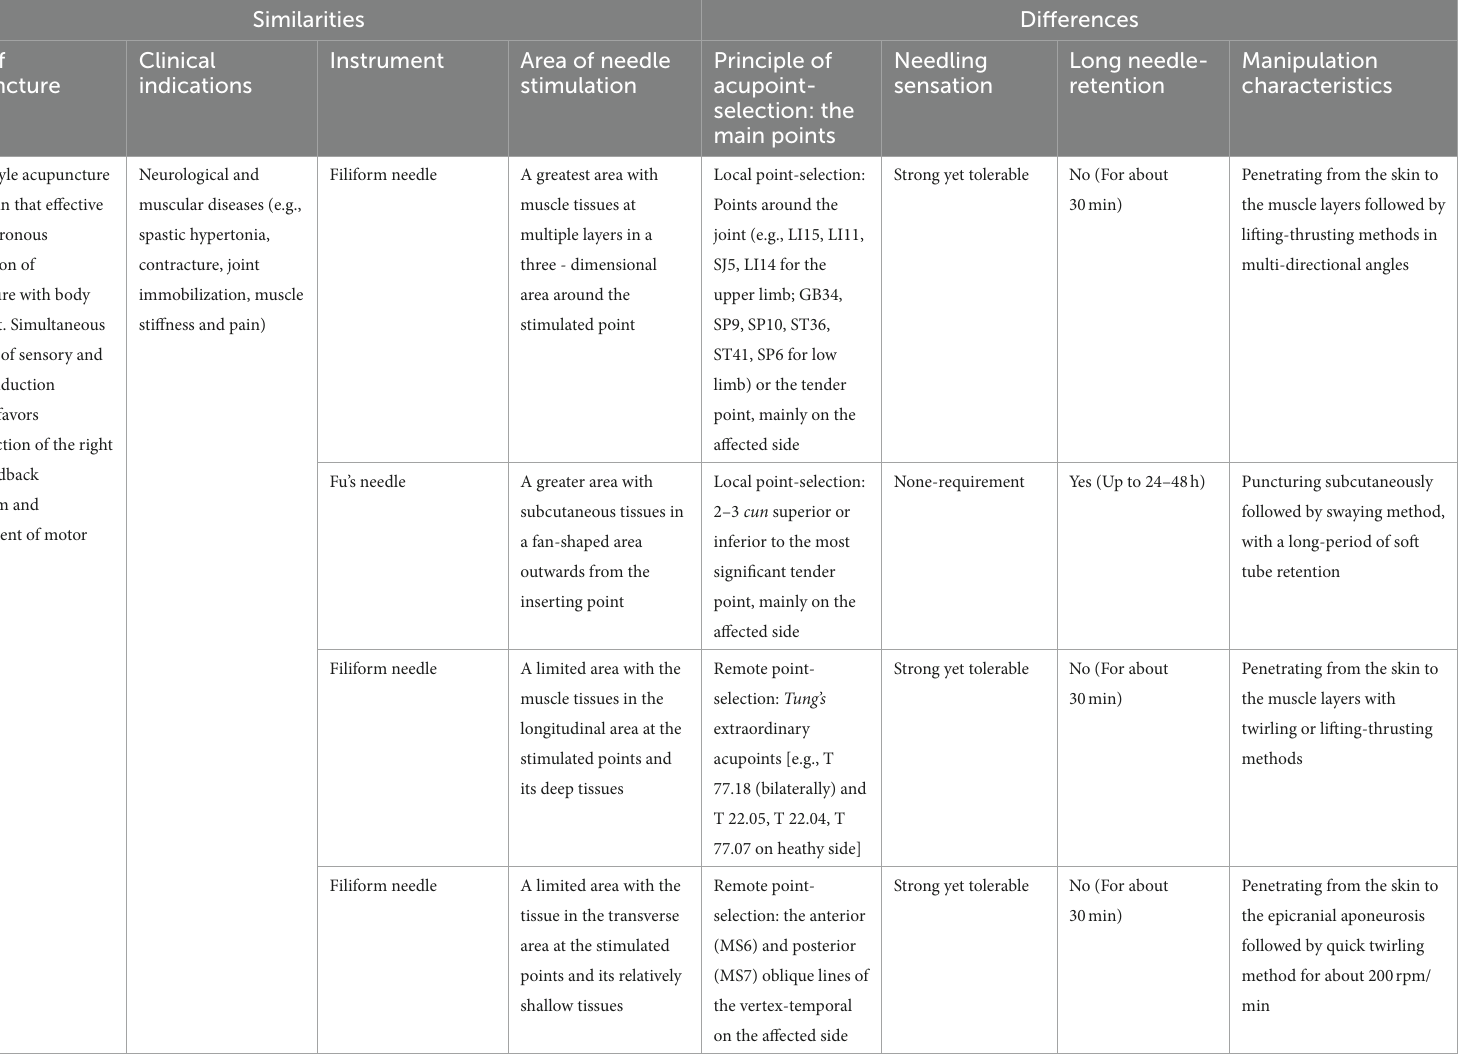
TABLE 1 Characteristics among the commonly used MSA